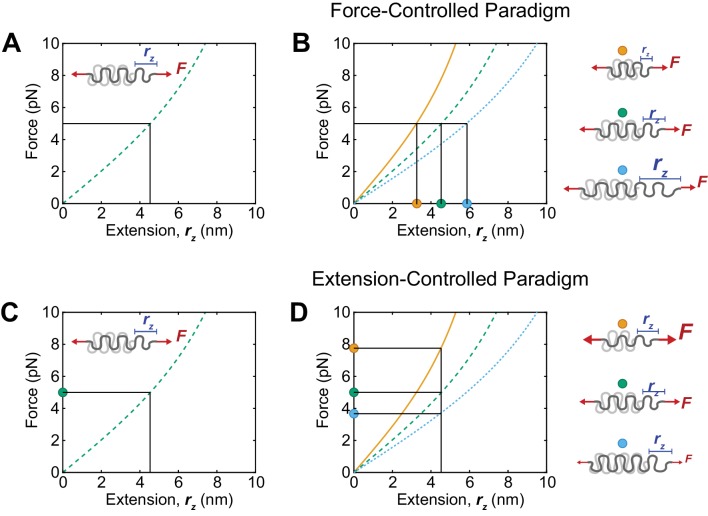
Schematic depiction of force-extension relationships and potential force- and extension-control paradigms.(A, B) A force-control paradigm cannot be detected if only a single sensor is used (A), but can be discerned if multiple sensors report the same forces, but distinct extensions (B). (C, D) An extension-control paradigm also cannot be detected if a single sensor is utilized (C), but can be uncovered if multiple sensors report the same extension and therefore distinct forces across a protein of interest (D). Curves are predictions of the force-extension curve of the WLC model with persistence lengths of 0.5 nm and contour lengths corresponding to the (GGSGGS)5,7,9 linkers utilized in this study (orange, green, and blue, respectively).